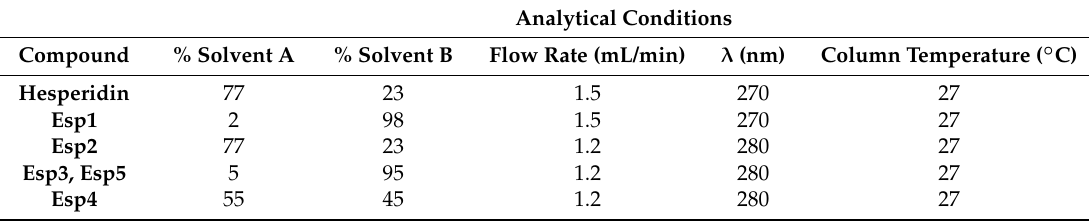
Table 1. Analytical parameters of HPLC analysis of hesperidin and its